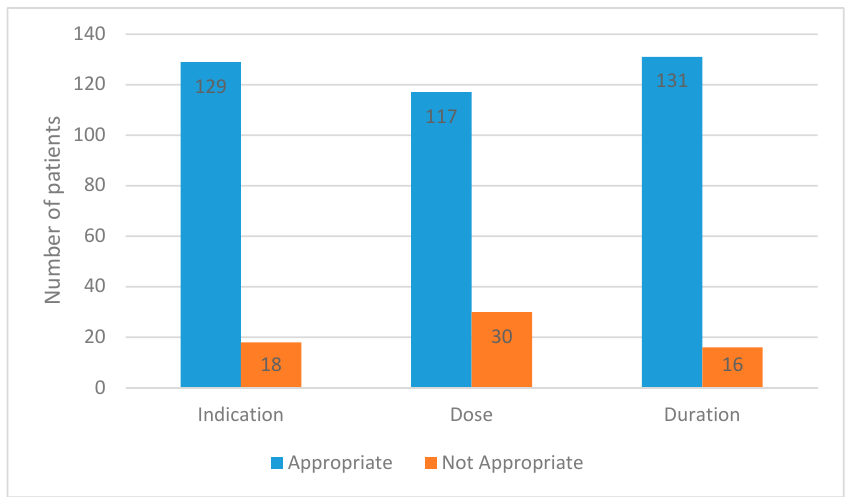
Figure 2. Appropriateness of carbapenem therapy per antimicrobial stewardship team during the implementation of carbapenem sparing strategies (April 2019).